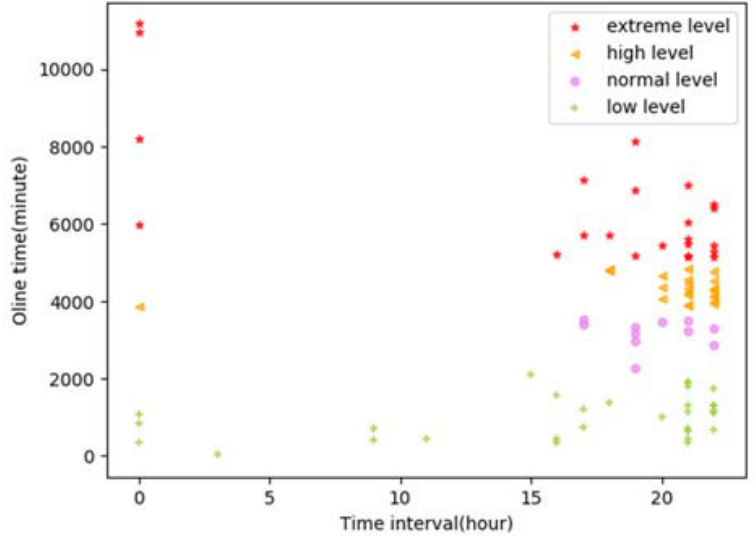
Figure 4. Online time preference by clustering.